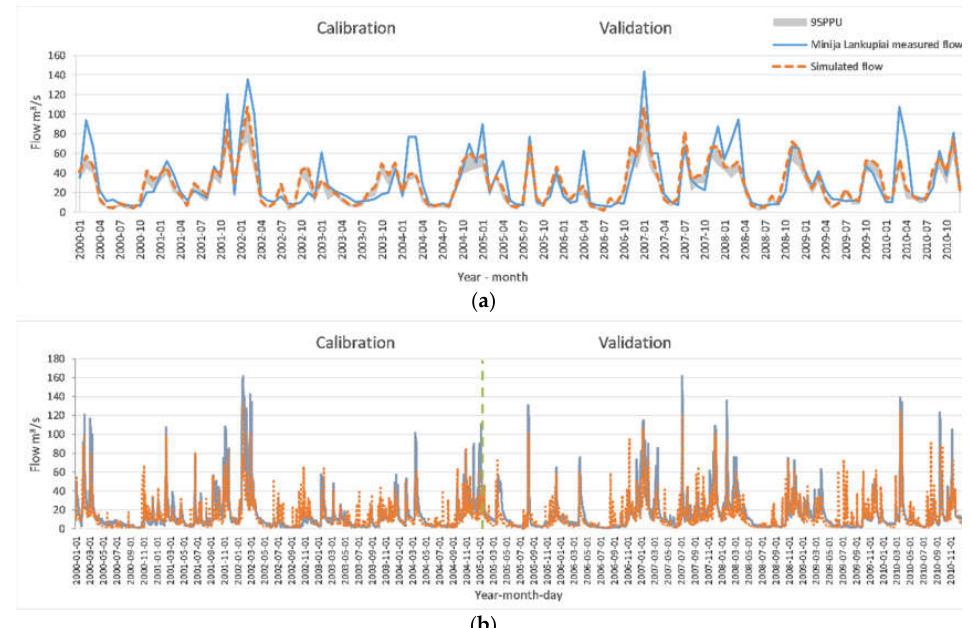
Figure 5. Hydrograph example of the Minija River at the Minija-Lankupiai station for the calibration and validation period: ( a )—monthly and ( b )—daily flows. and validation period: ( a )—monthly and ( b )—daily